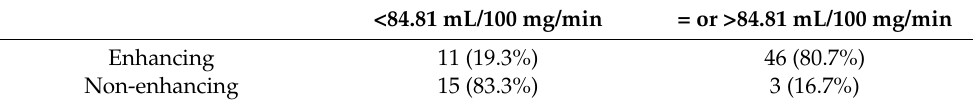
Table 5. Contrast enhancement and prediction based upon defined optimal